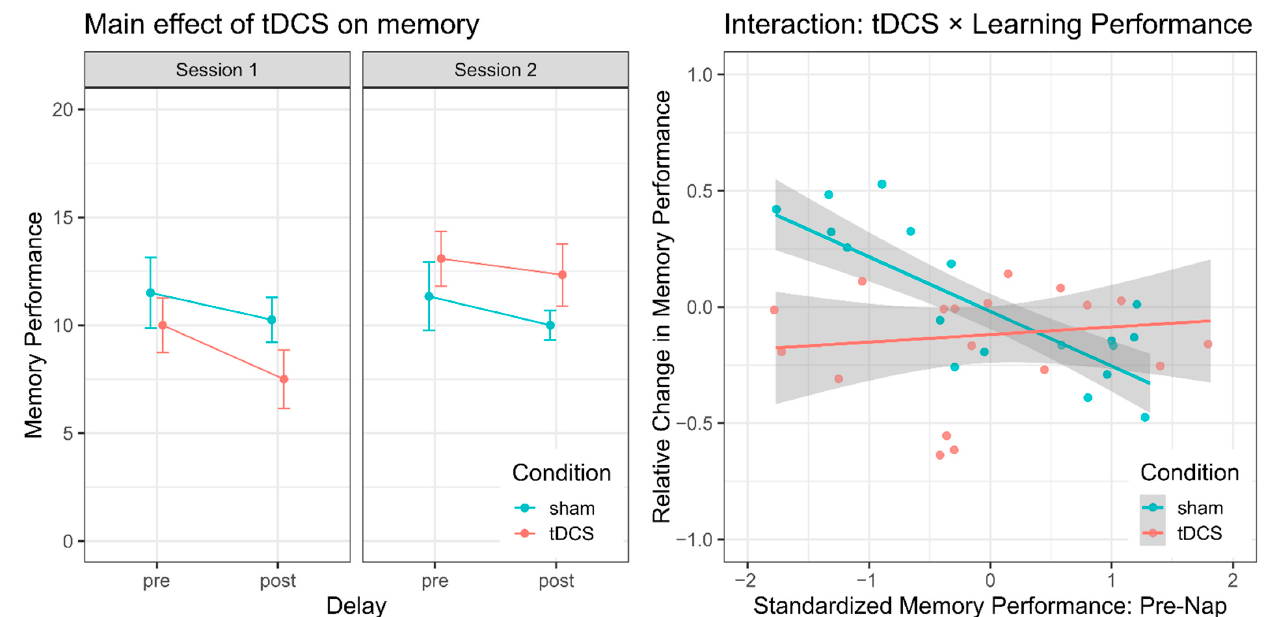
Figure 5. Effect of tDCS on memory performance. ( Left panel ): mean memory performance (with standard error of the mean (SEM)) for the pre- and post-nap memory test separately for the tDCS and the sham condition and for test session 1 and 2. ( Right panel ): correlation between standardized pre-nap performance and the relative change in performance (post-nap minus pre-nap divided by pre-nap performance) separately for the tDCS and the sham condition.